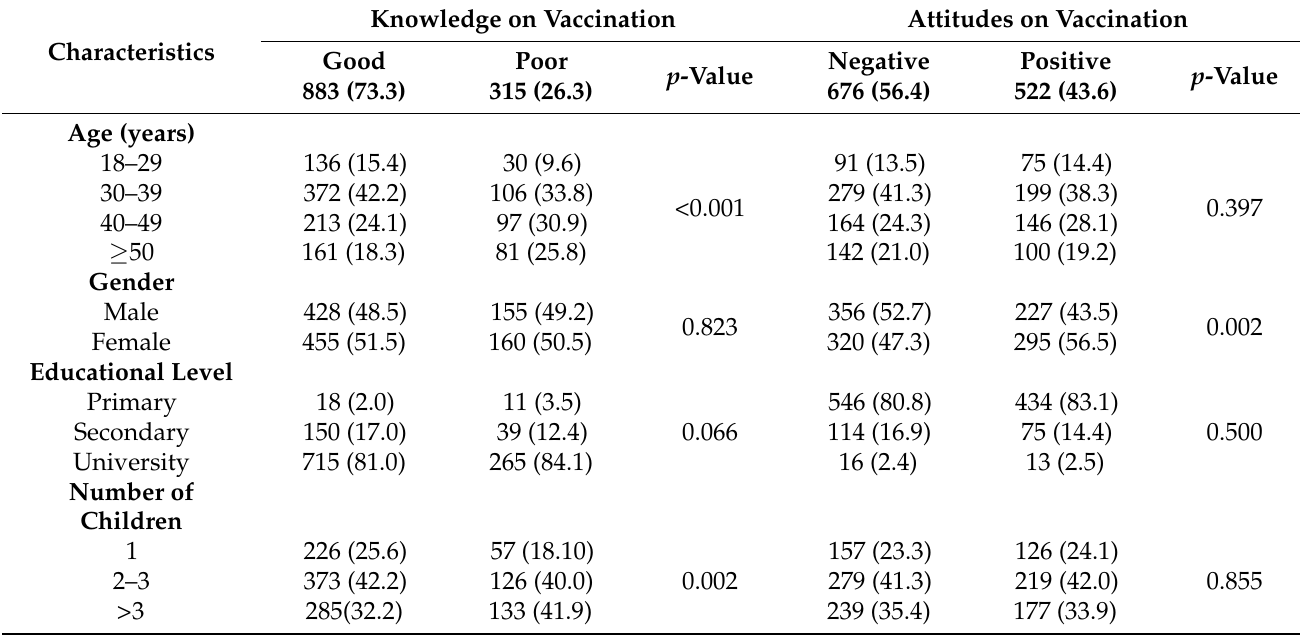
Table 4. Association between demographic characteristics toward knowledge and attitudes on